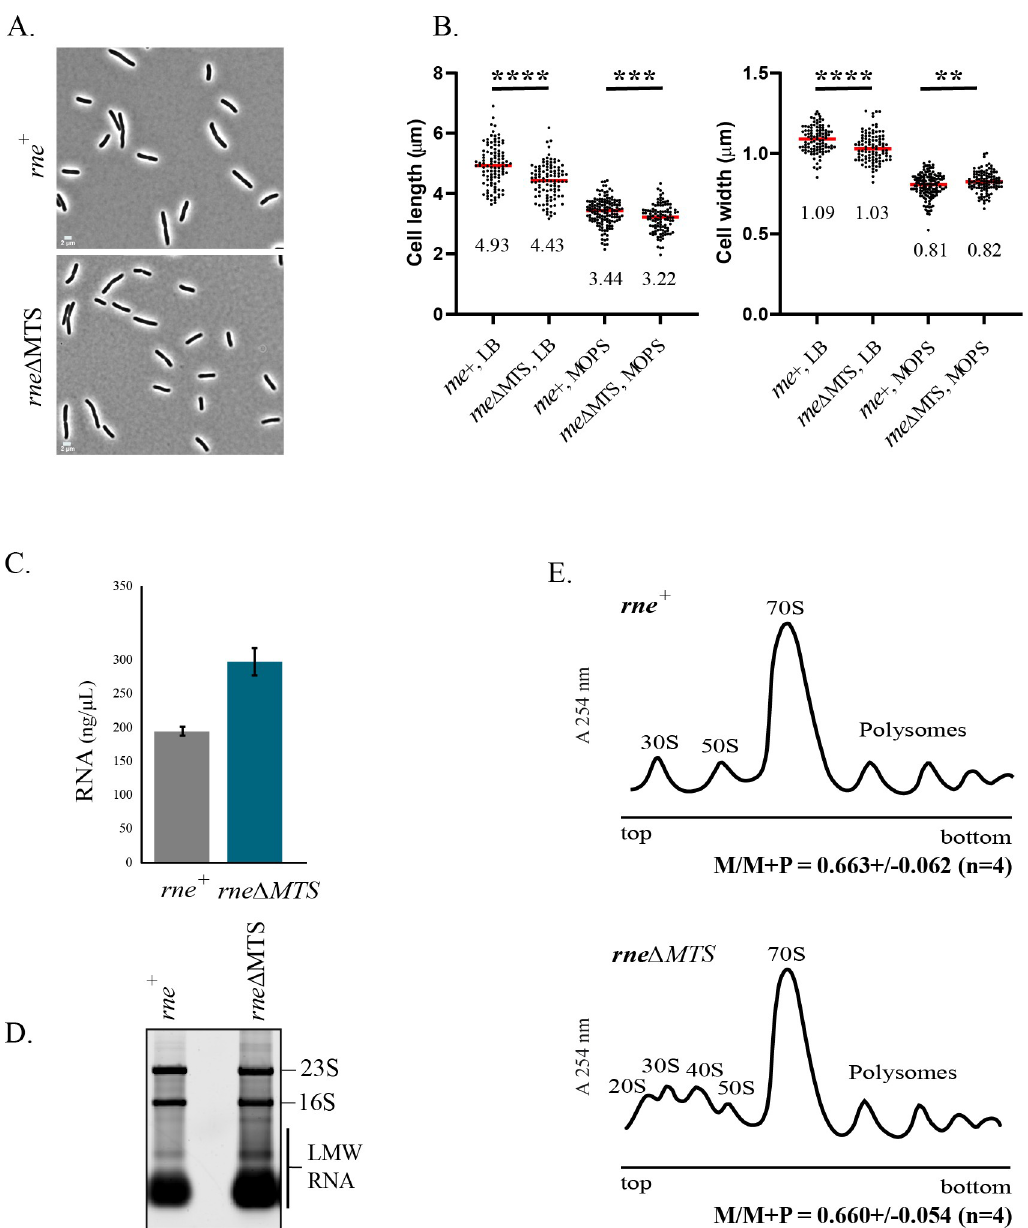
Fig 1. Cell size, RNA content, and polysome profiles. (A) Phase-contrast images. Micrographs of strains expressing either membrane-bound ( rne + ) or cytoplasmic ( rne Δ MTS) RNase E were made at the same magnification. (B) Cell size. Lengths and widths were measured as described [39]. Scatter plots showing median cell length and width of rne + and rne Δ MTS strains grown in either LB or MOPS media. Cells from 2 independent experiments ( n > 100) were analyzed by ImageJ using the MicrobeJ plugin. Median length and widths ( μ m) are shown below each plot. P values were calculated using a parametric unpaired t test (GraphPad Prism): ���� = P < 0.0001; ��� = 0.0001 < ; P < 0.001; �� = 0.001 < P < 0.01. (C) RNA yield. Cultures of the rne + and rne Δ MTS strains were grown to OD 600 = 0.4 in LB medium. RNA was extracted from equal volumes of culture. Purified total RNA was eluted in equal volumes of water, and concentrations were determined by UV absorption at 260 nm. Average and standard deviation of RNA concentration from 3 independent experiments are shown. (D) Ribosomal RNA levels. Equal volumes of total RNA (Fig 1C) separated by agarose gel electrophoresis and staining with SybrGreen. Levels of 16S and 23S are comparable in the 2 strains, whereas there is 30% more Low Molecular Weigh RNA (LMW RNA) in the rne Δ MTS strain as estimated by quantification of fluorescence levels (Image Lab, Bio-Rad). (E) Polysome profiles. Clarified cell lysates prepared from equal volumes of cell cultures grown to OD 600 = 0.4 in LB medium were fractionated by velocity sedimentation on 10%– 40% sucrose gradients. Sedimentation is from left to right. Upper panel, rne + strain; lower panel, rne Δ MTS strain. Peaks corresponding to 30S and 50S ribosomal subunits, 70S ribosomes and polysomes are indicated. 20S and 40S particles in